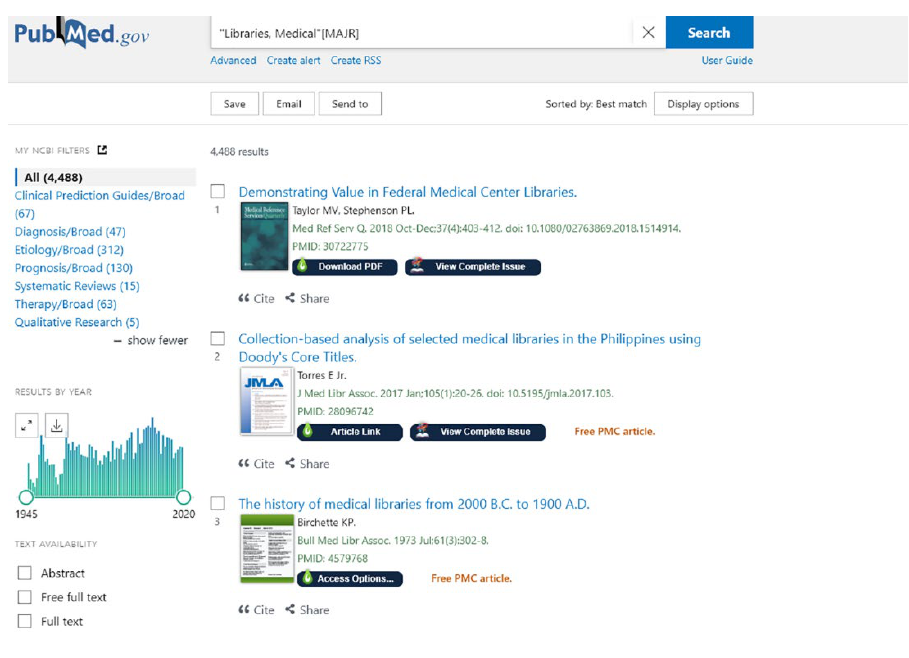
Figure 1 LibKey Nomad integration in